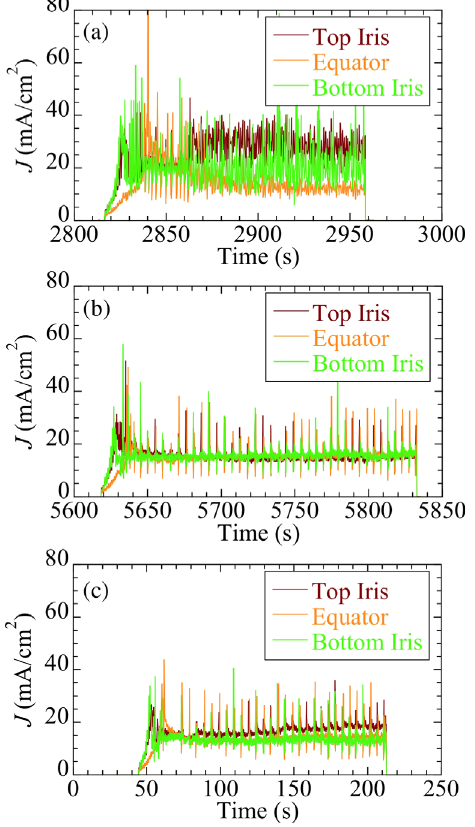
FIG. 14. Coupon currents in the top cell at a cathode rotation of 20 rpm, a cavity temperature of ∼ 15 °C, and under the dual- flow condition, where the acid in the cavity is flowed at a rate of 5 L = min and in the cathode housing at 5 (a), 10 (b), and 20 L = min (c).